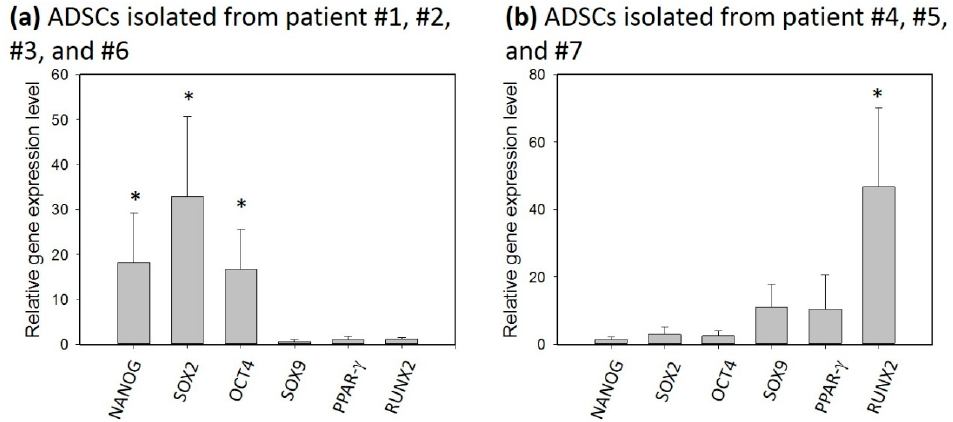
Figure 9. Investigation of the gene expression of the ADSCs after the stimulation of the multi-axial tensile strain. ( a ) The ADSCs were isolated from patients #1, #2, #3, and #6. ( b ) The ADSCs were isolated from patients #4, #5, and #7. The ADSCs were respectively stimulated by the multi-axial tensile strain for three days. The data were generated from three repeated experiments for each tissue sample. The data are presented as mean ± standard error. The results were analyzed using one-way analysis of variance (ANOVA). Statistical significance was compared to the control and is indicated as * for p < 0.05.